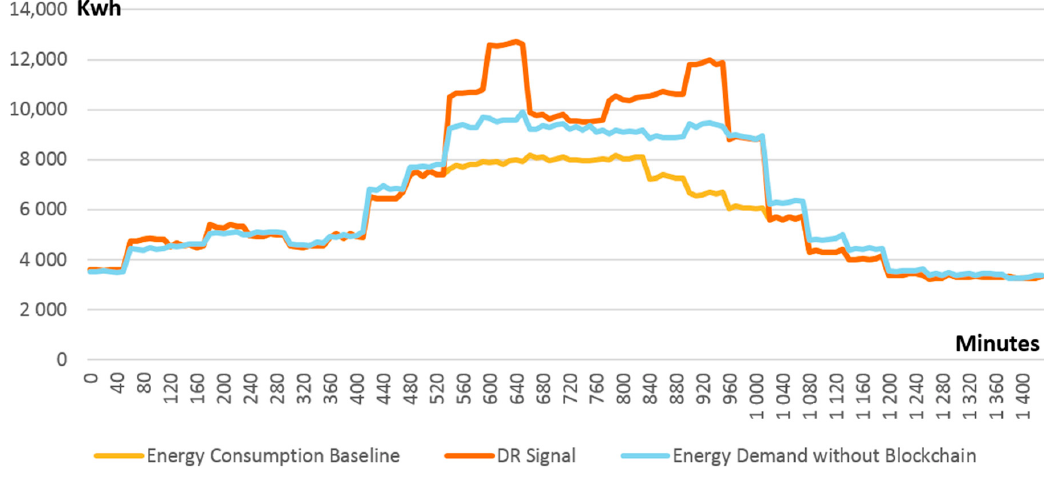
Figure 9. Actual vs. expected energy demand without blockchain based control.